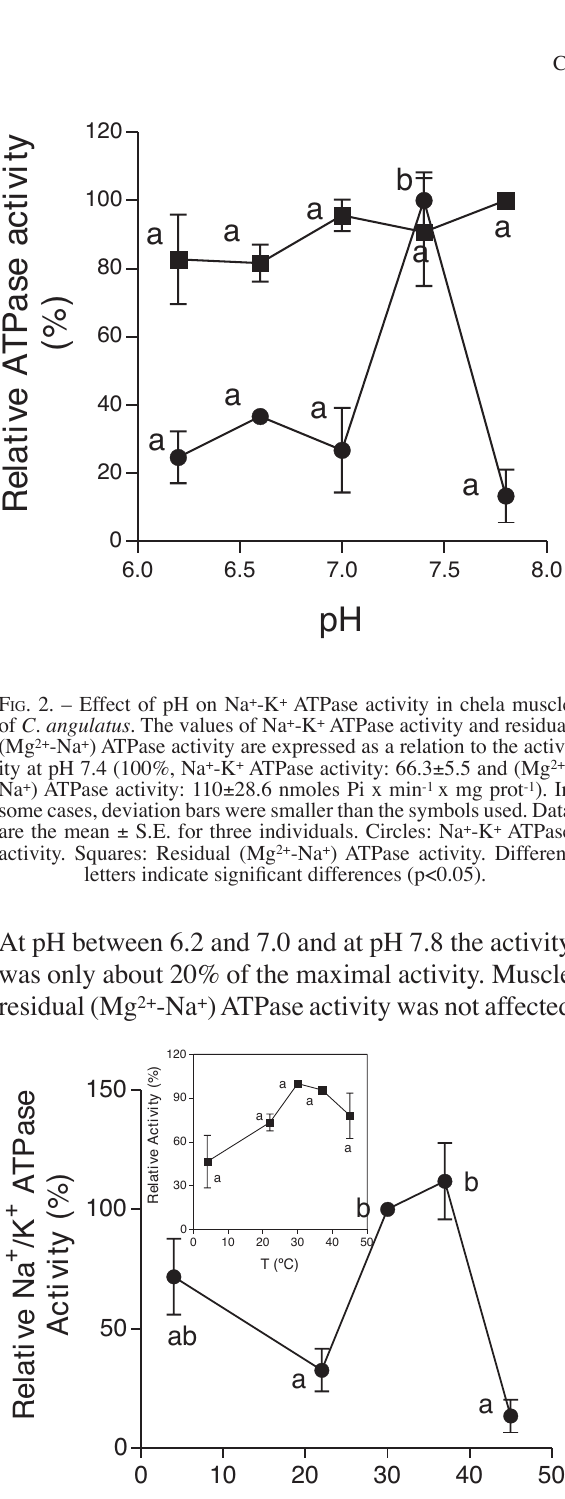
n=6n=6n=6 n=6n=3 n=3n=3n=3n=3 n=3n=3 f ig . 4. – aP activity in chela muscle of C. angulatus in the absence and presence of 16 mM levamisole. data are the mean ±